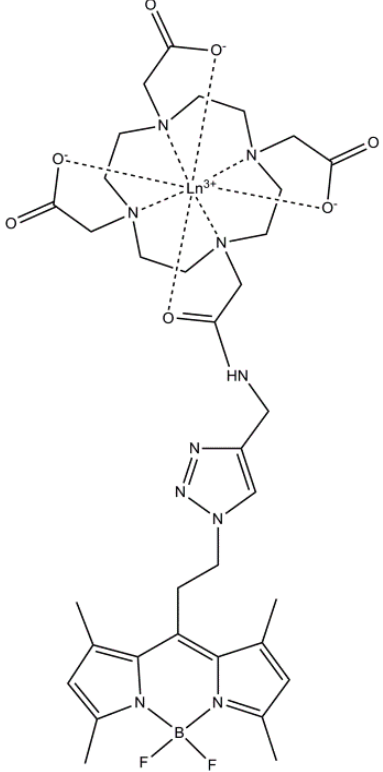
Figure 12. Chemical structure of Products 9 and 10